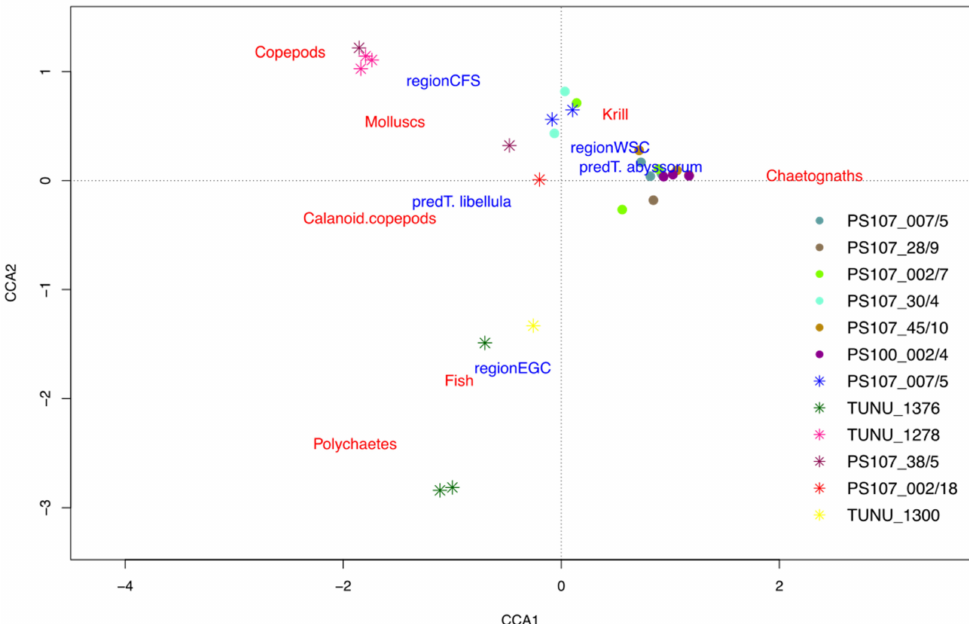
Figure 2. Canonical correspondence analyses ( CCA) of the diet of the two predators. Colors indicate different stations. Stars represent sampling stations of T. libellula and dots indicate sampling stations of T. abyssorum . Data is separated by geographical regions and predator species (both as blue text), regions were identified by geographical regions indicated in Figure 1. Only 50% of the most abundant prey species were displayed (red text). The first axis (CCA1) separates the predator species, with T. libellula being displayed on the left-hand side and T. abyssorum on the right-hand side. The second axis (CCA2) separates the different geographical regions from each other.